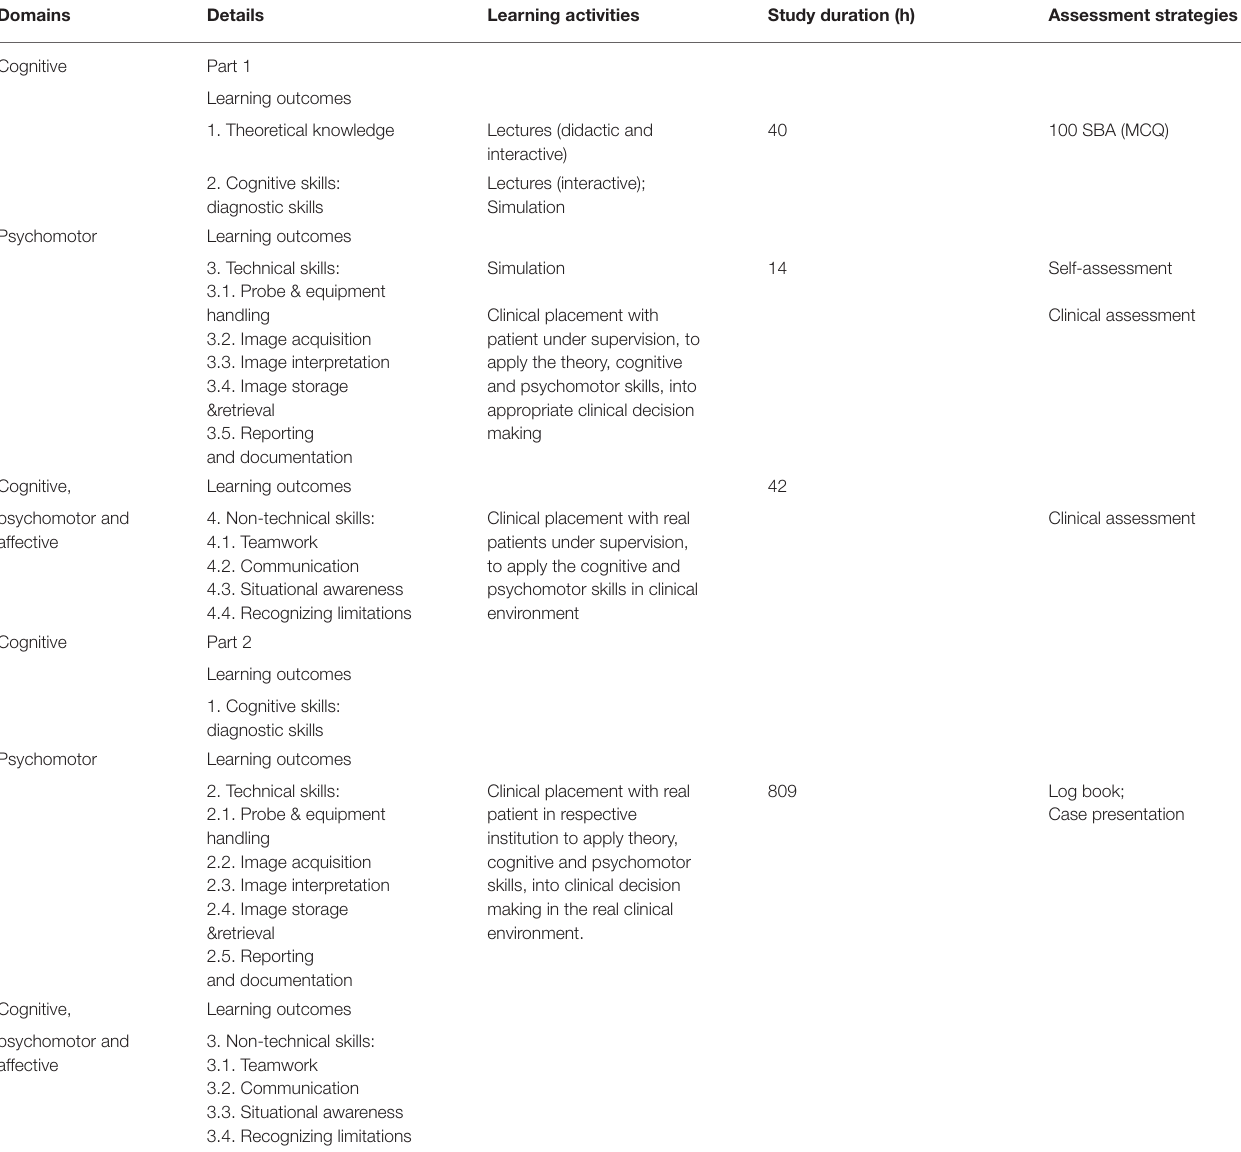
TABLE 1 | Summary of teaching and learning activities and strategies and assessment.